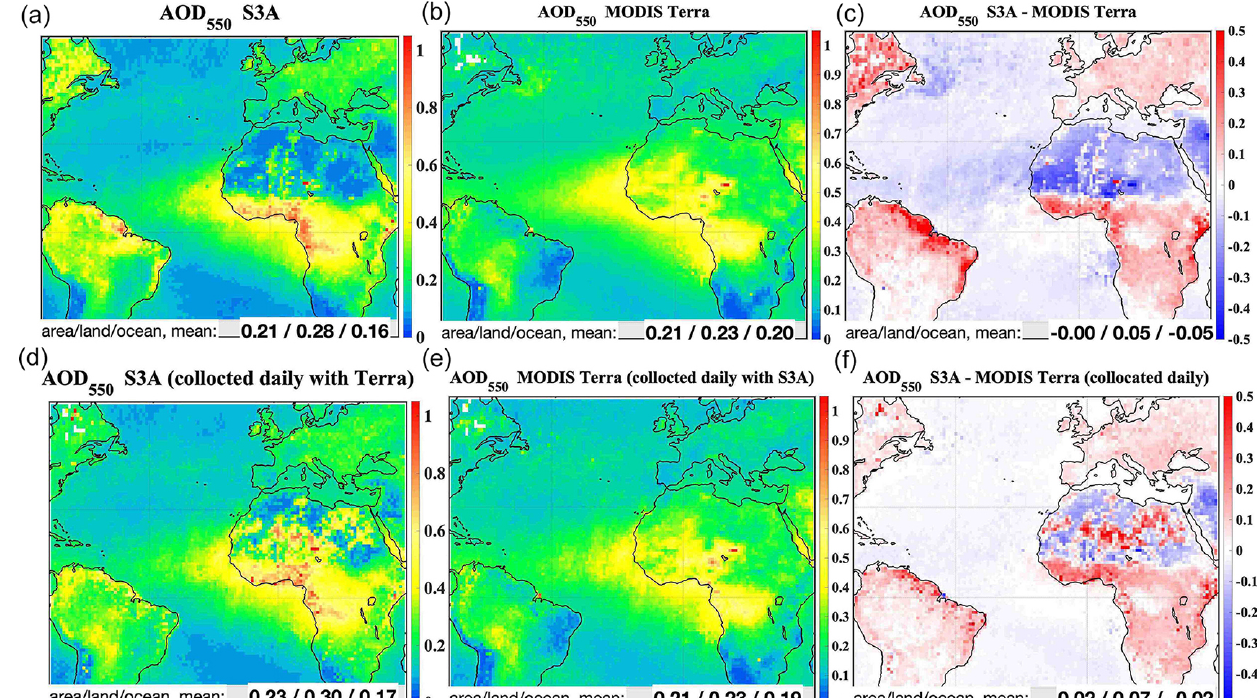
Figure 30. For the year 2020, annual S3A SY_2_AOD (a, d) , MODIS Terra (b, e) AOD, and the difference between S3A and MODIS Terra (c, f) AOD. Annual means are calculated from monthly aggregates combined from all data available in each product (a–c) and pixels of collocated daily AOD (d–f) . AOD mean and the difference between SY_2 and MODIS AOD for the whole area, as well as separately for land and ocean, are shown on the